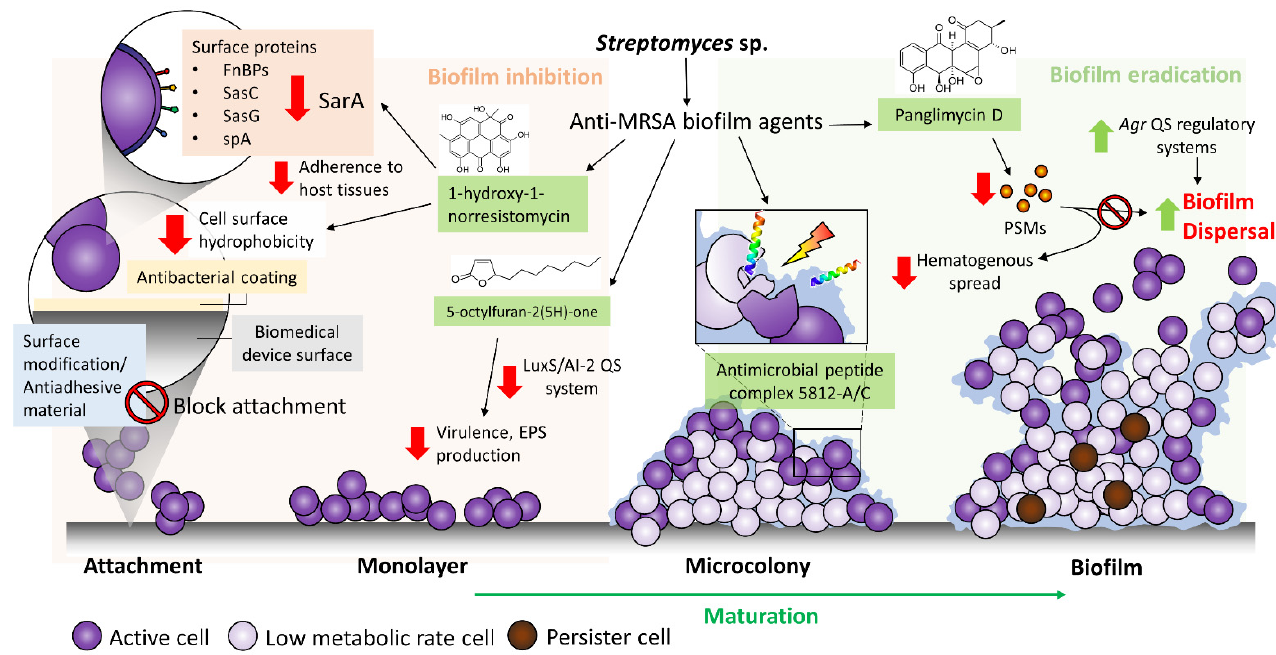
Figure 2. The strategies of biofilm inhibition and biofilm eradication employed by the anti-MRSA biofilm agents derived from Streptomyces sp.